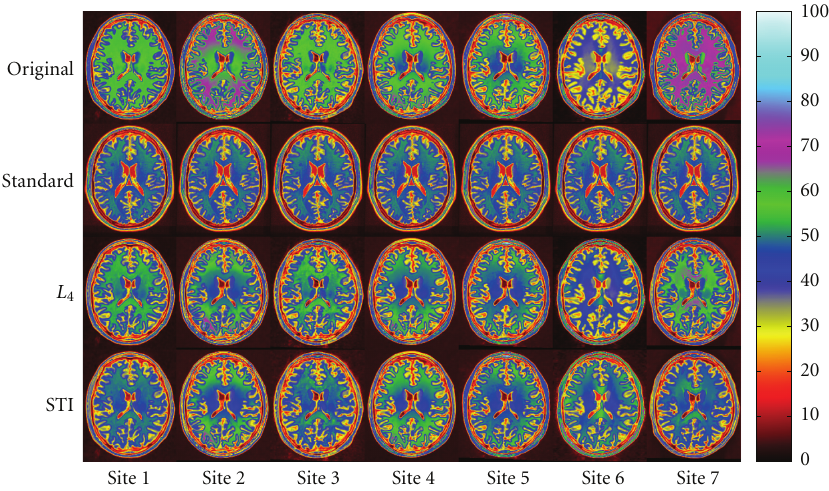
Figure 2: Standardized images for Subject 1 in the Pilot E-ADNI dataset. From top to bottom: linearly registered input images, standard image, and images standardized with L 4 and STI, respectively. From left to right: images for Sites 1 to 7. Color coding enhances intensity di ff